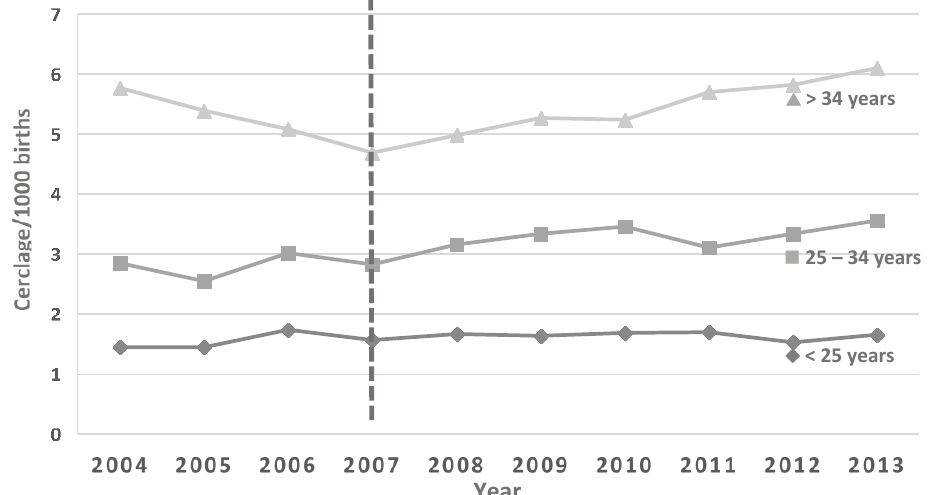
Figure 3. Maternal age-stratified incidence rates for cervical cerclage (procedures per 1000 births) in Australia for the period 2004 until 2013. There was no increase in the rate of cerclage in the age group less than 25 years across the study period (R = 0.46; aR 2 = 0.11; p = 0.19), but significant increases since 2007 in the 25 to 34 year age group (R = 0.84; aR 2 = 0.67; p = 0.002) and the 35 years and older age group (R = 0.99; aR 2 = 0.96; p < 0.005).